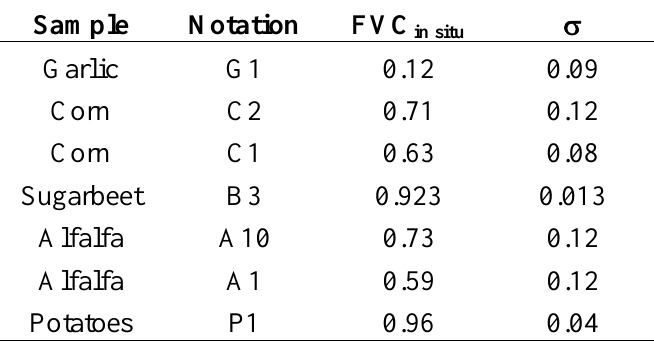
Table 1. Fractional vegetation cover measured in situ over different samples using ) and standard deviation values (  ). hemispherical photographs (FVC in situ